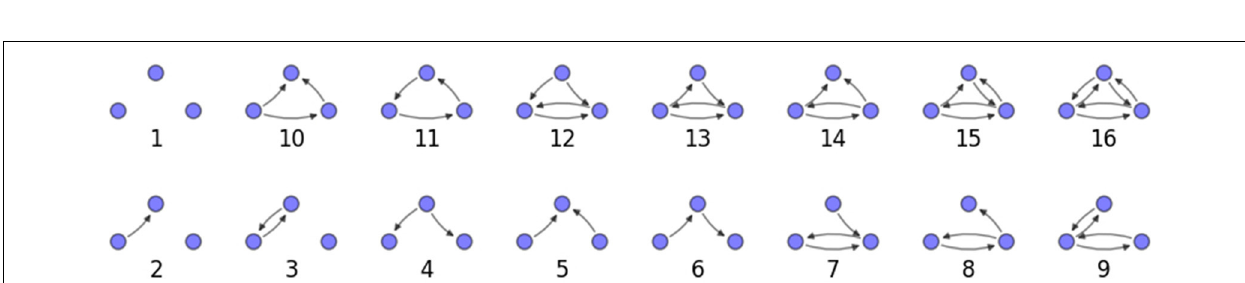
FIGURE 6 | Common neighbor clustering for 100 µ m slice: pairwise connection probability as a function of number of commonly connected neighbors. Error bars indicate standard error of the mean. Average over five populations.